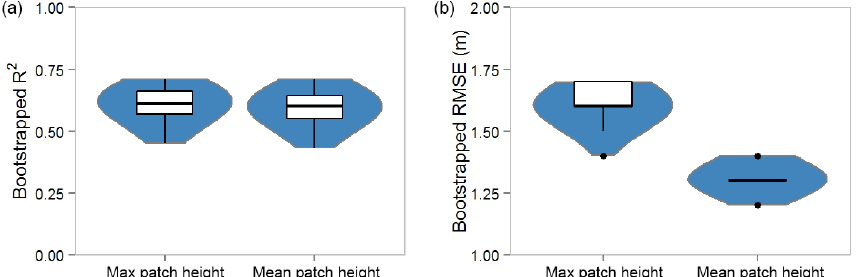
Figure 6. The bootstrap-derived distributions (shown as violin plots, blue) of the random forest model’s (a) R 2 and (b) RMSE for the indirect forest patch height prediction method whereby all spaceborne variables were used to predict maximum and mean forest patch height. Box plots (white) show the 25th and 75th percentiles (lower and upper lines), median (dark line), and 1.5 × the interquartile range (whiskers). Data beyond the whiskers are shown as points.